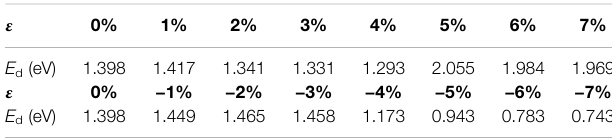
TABLE 7 | Activation energies of P b defect depassivations under tensile and compressive strains.